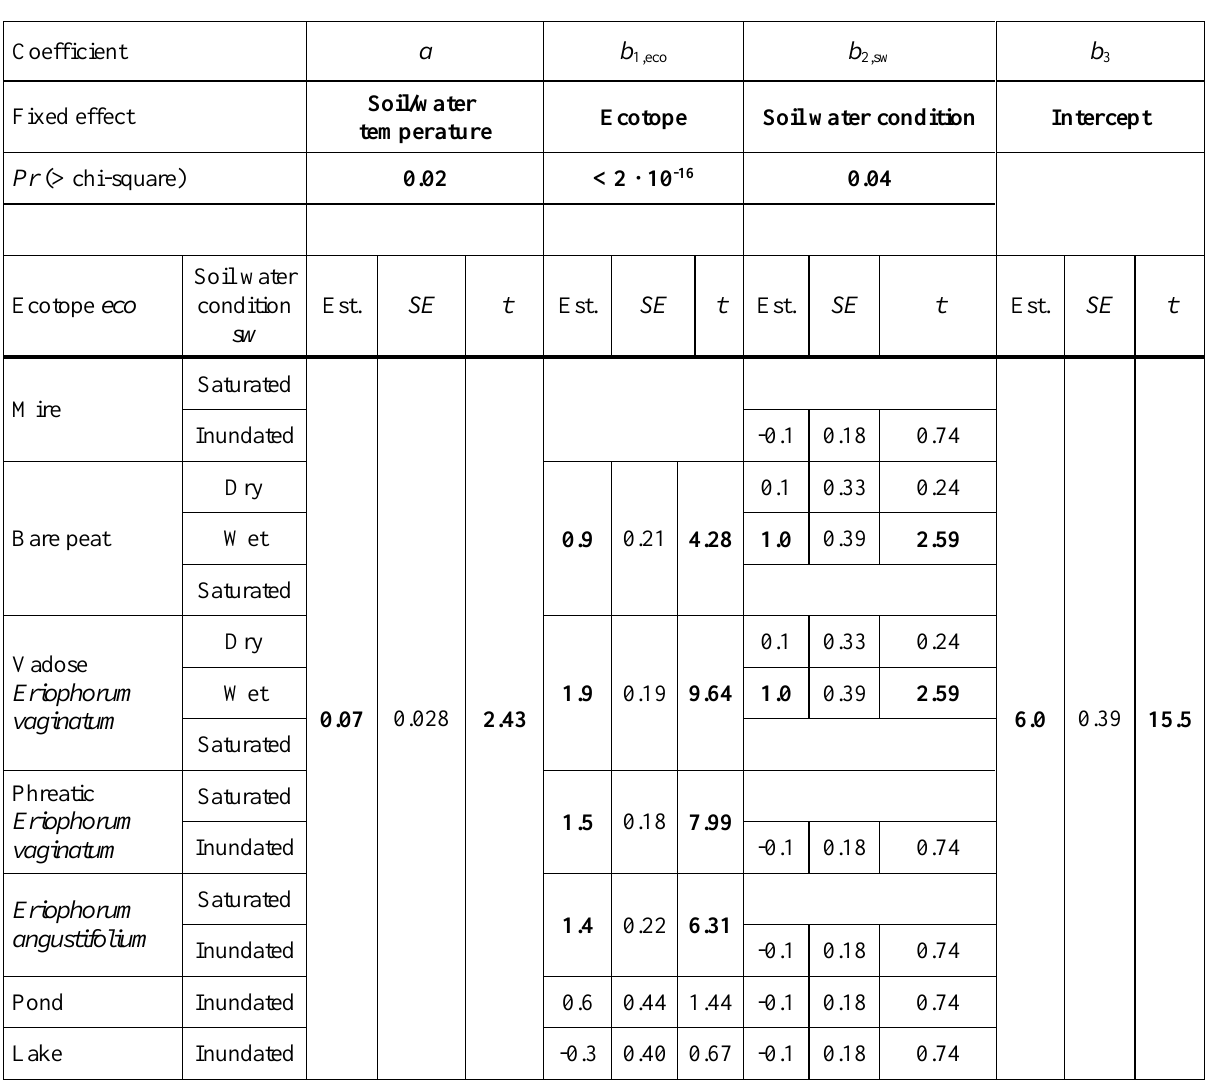
Table 5. Parameters of the linear mixed effects model for CO 2 flux to the atmosphere from the ecotopes. Significant fixed effects and coefficients in bold. Reference level for ecotope: mire; reference level for soil water condition: saturated. Est. = estimate; SE = standard error; t = t